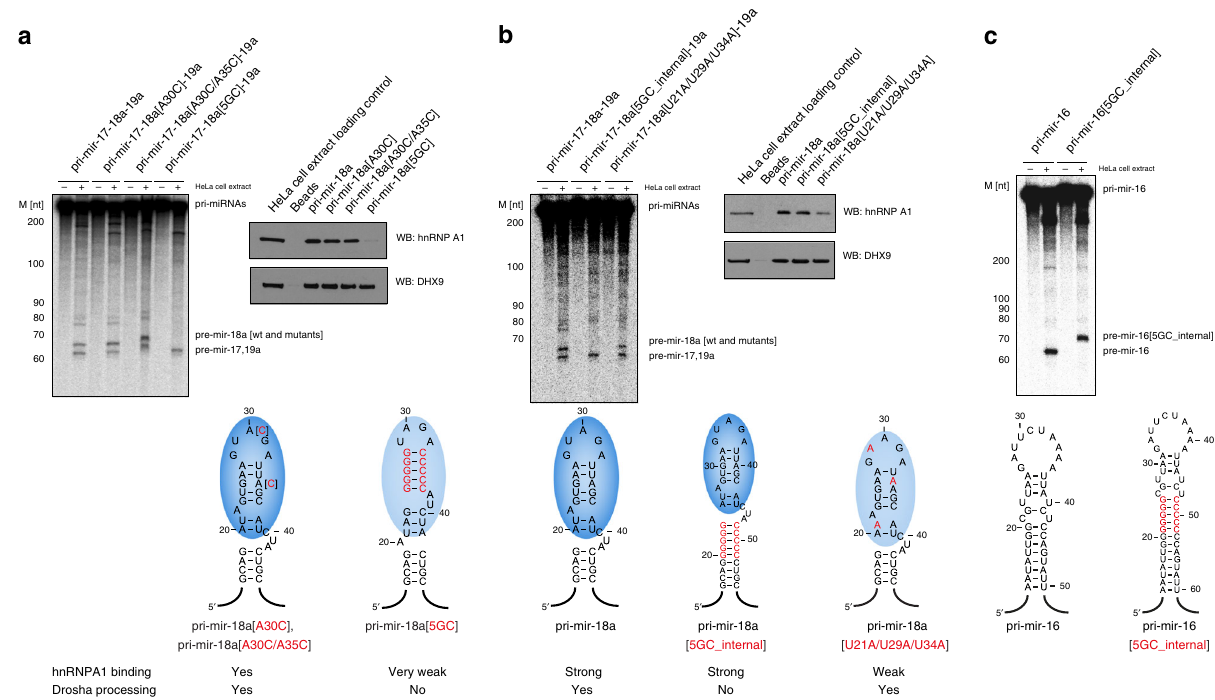
Fig. 6 Mechanism of hnRNP A1 stimulation of pri-miRNA processing. a Pri-mir-18a with single or double A → C point mutations still bind hnRNP A1 in RNA pull-down assays and are processed by Drosha (in vitro processing assay with the pri-mir-17-18a-19a cluster, wildtype and mutants), whereas pri-mir-18a mutant with a 5GC clamp does not bind hnRNP A1 (RNA pull-down assay is shown on the right) and is not processed by Drosha. b Pri-mir-18a with a 5GC_internal clamp and wild-type terminal loop binds hnRNP A1 but is not processed by Drosha. Pri-mir-18a with triple mutations [U21A/U29A/U34A] binds hnRNP A1 with lower af fi nity than the wild-type pri-mir-18a but is still ef fi ciently processed by Drosha. c In vitro processing assay of pri-mir-16 with 5GC_internal clamp shows ef fi cient processing by Drosha, similar to pri-mir-16